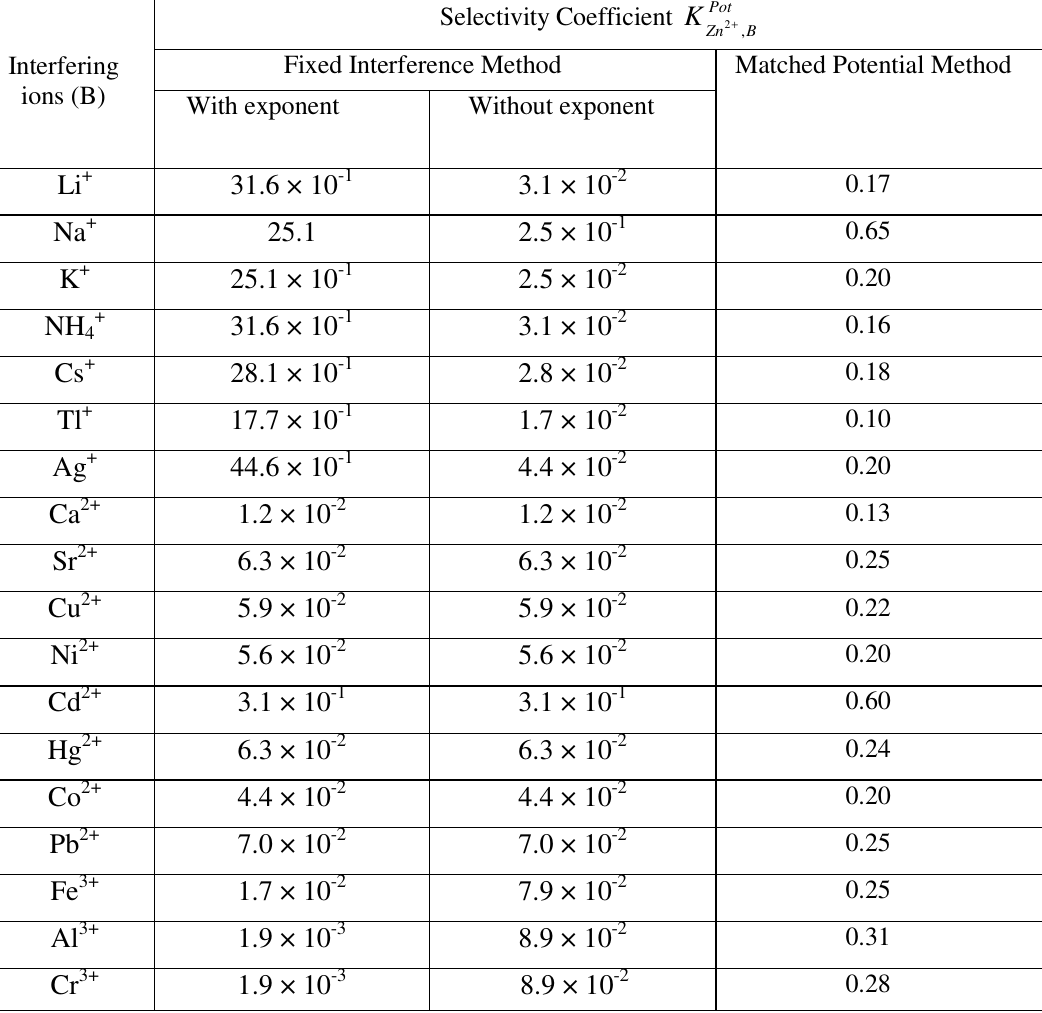
Table 4 : Potentiometric selectivity coefficient values Pot concentration of interfering ions (B), observed for Zn 2+ (sensor no. 2) using Fixed Interference and Matched Potential